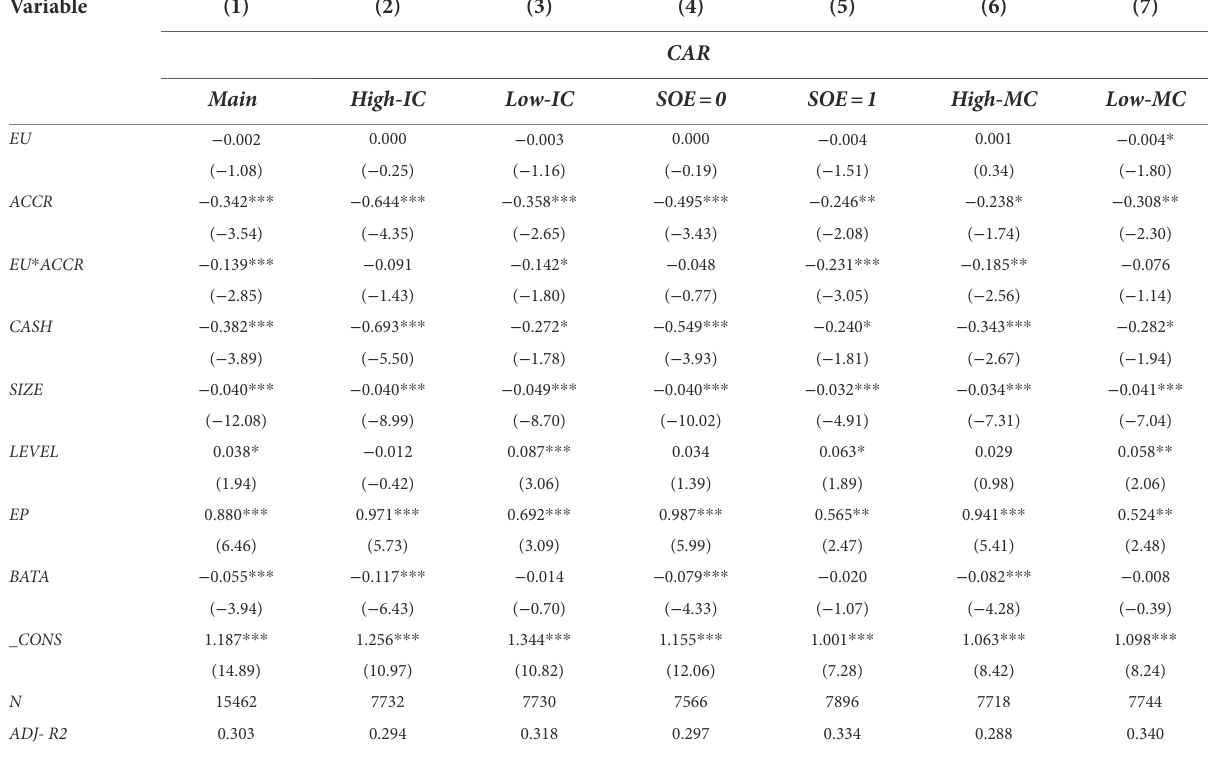
TABLE 9 Robustness test: Eliminating samples in 2008.